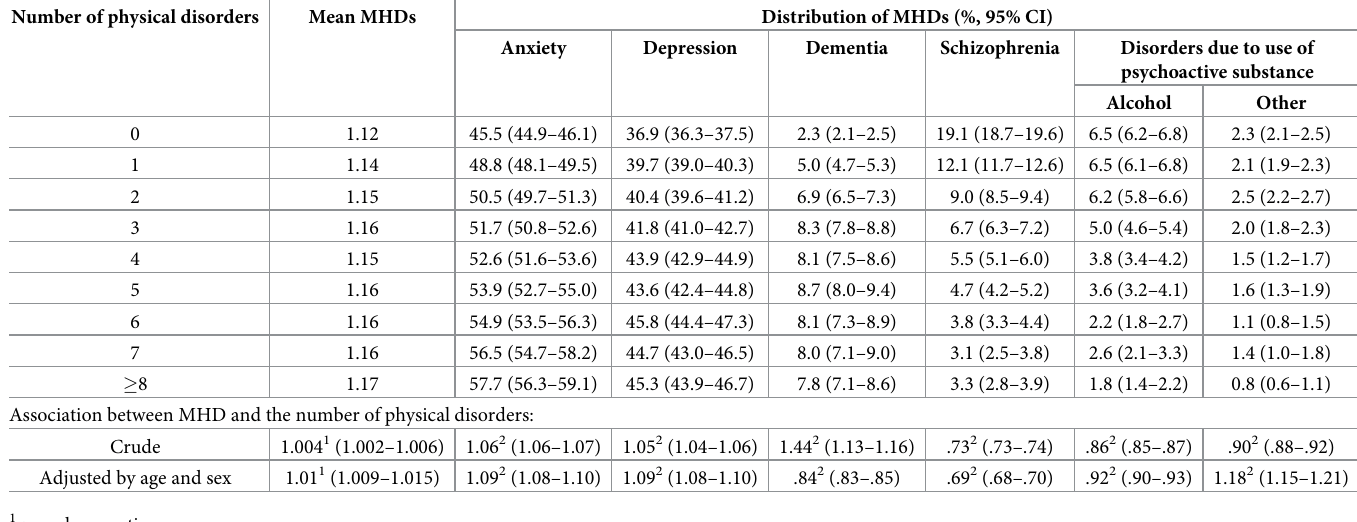
Table 2. The mean MHDs, distribution and associations between MHDs and the number of physical comorbidities: Crude and adjusted for age and sex. Number of physical